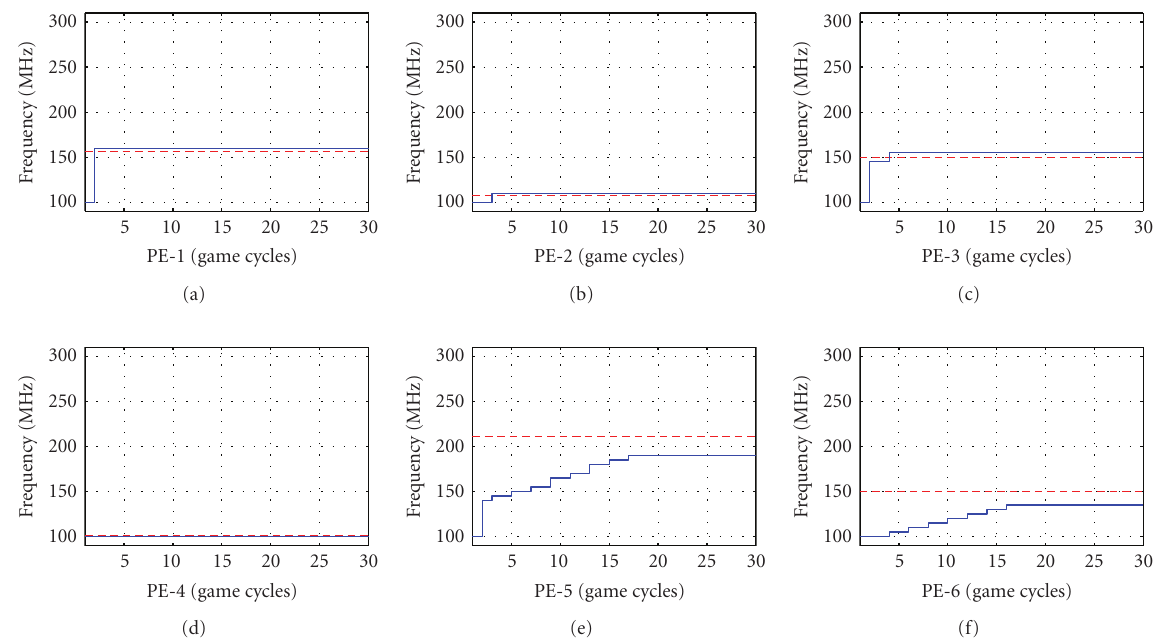
Figure 8: Dynamic response of a 3 × 2 processor array for a given 6-task application with w syn = 0 . 75 and w temp = 0 . 25. The solid line shows the evolution of the chosen frequency for each PE. The NE is defined by f 1 = 160, f 2 = 110, f 3 = 155, f 4 = 100, f 5 = 190, and f 6 = 135MHz. The dashed line is the reference solution calculated by Matlab: f 1 = 156, f 2 = 107, f 3 = 149, f 4 = 100, f 5 = 210, and f 6 = 149MHz.